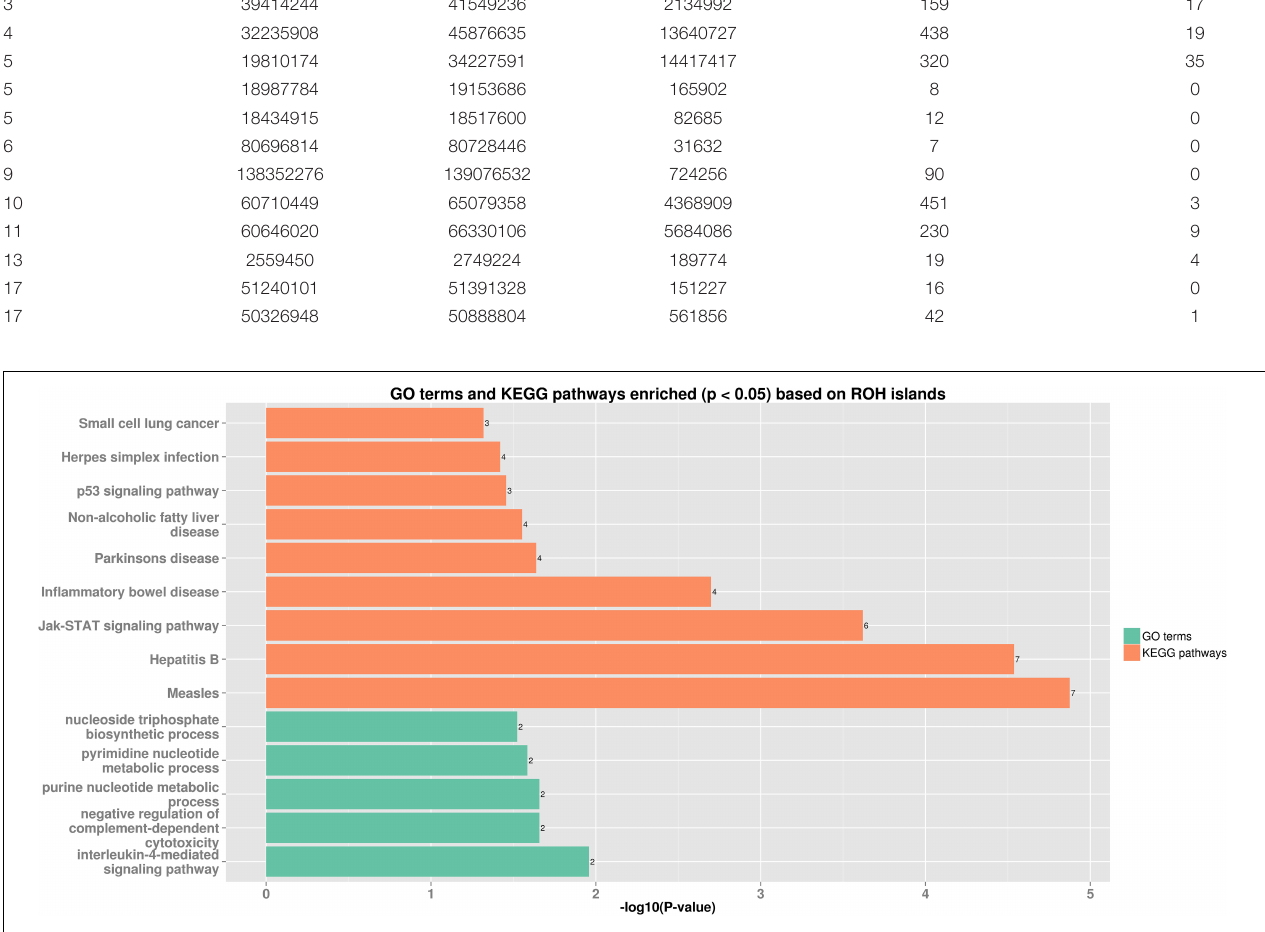
FIGURE 4 | Bar plot of GO terms and KEGG pathways enriched ( p < 0.05) based on ROH islands. Orange bars show enriched GO terms, and green bars show KEGG pathways.